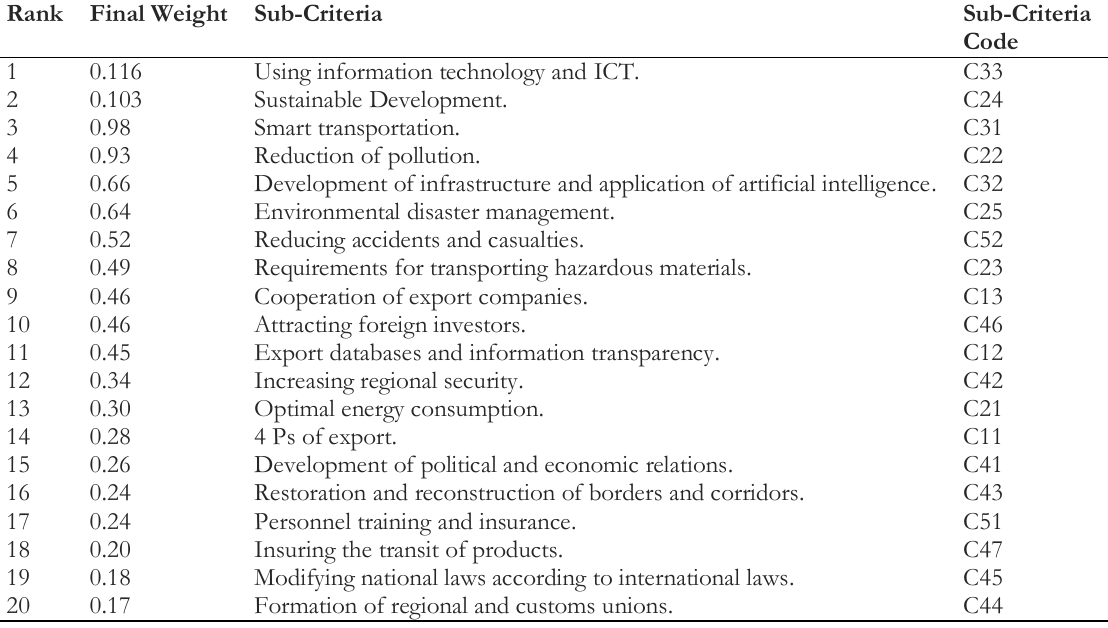
Table 12. Final weight and rank of sub-criteria.